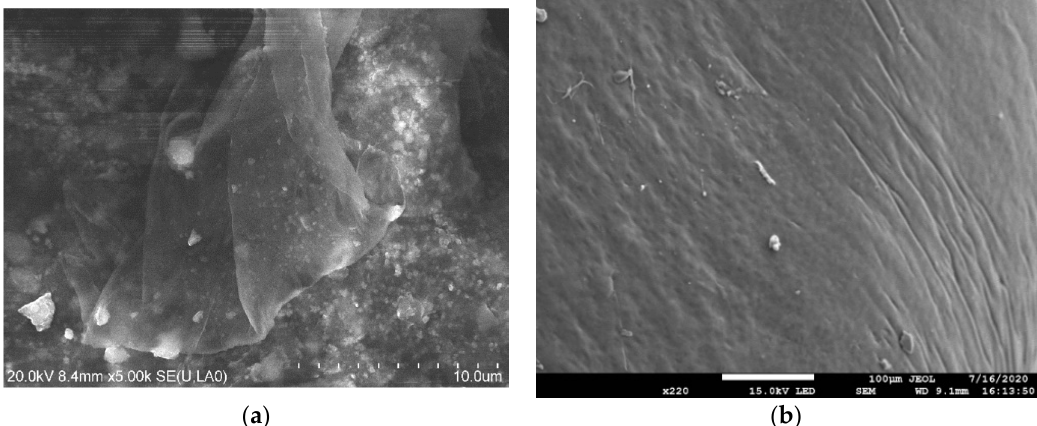
Figure 1. SEM images: ( a ) interspersed graphene flakes, ( b ) graphene layer adhered uniformly on the TiO 2 base metal surface.